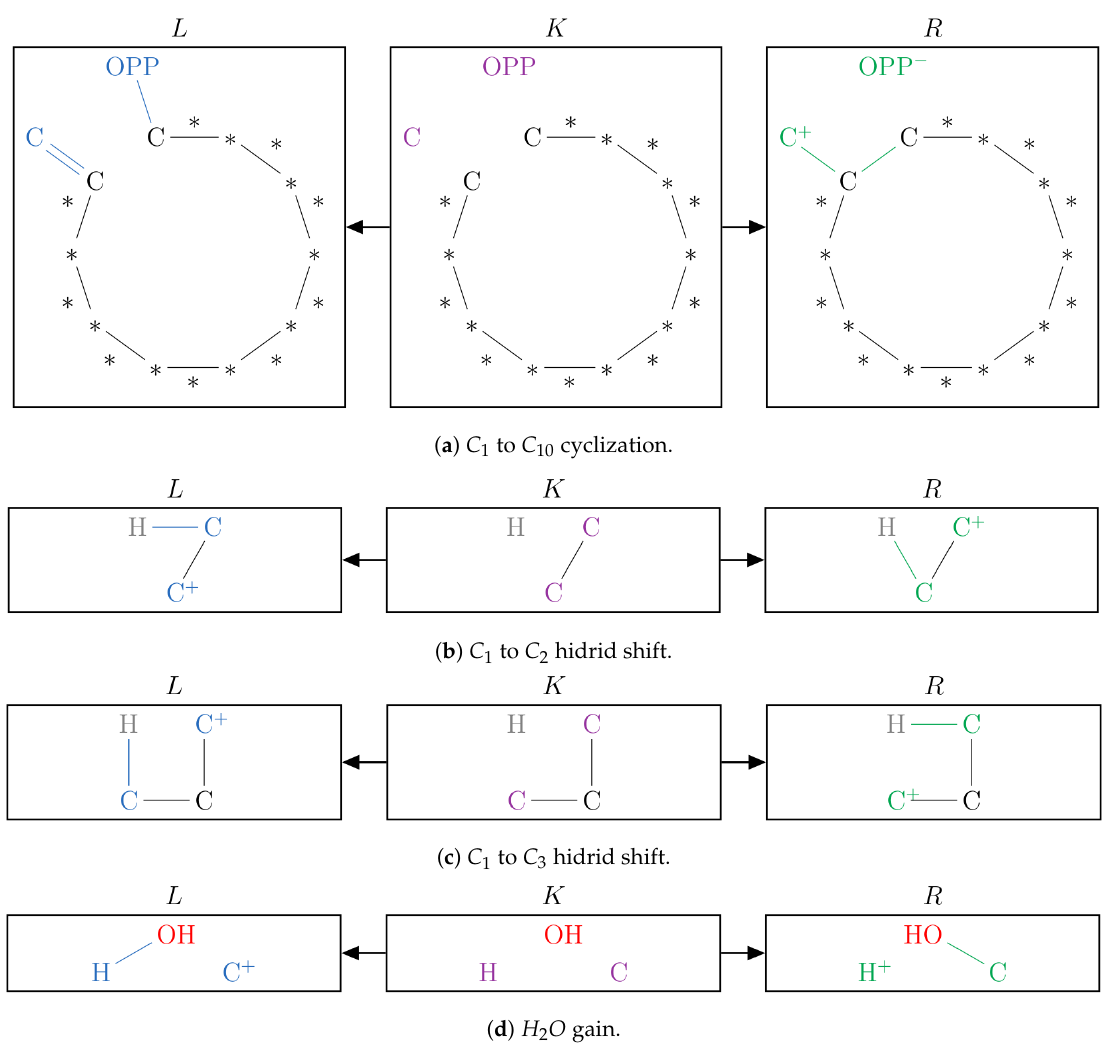
Figure 9. The graphical representation of the set of graph grammar rules that, together with Rules of Figures 7 and 8, were used in Simulation